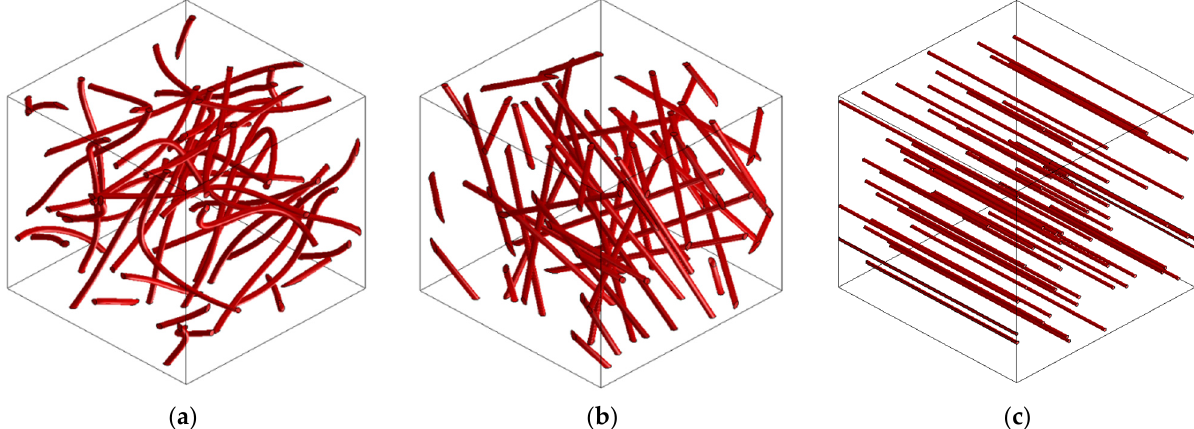
Figure 4. ( a ) RVE of realistic CNT composite; ( b ) RVE of a simplified CNT composite; ( c ) RVE with aligned inclusions.